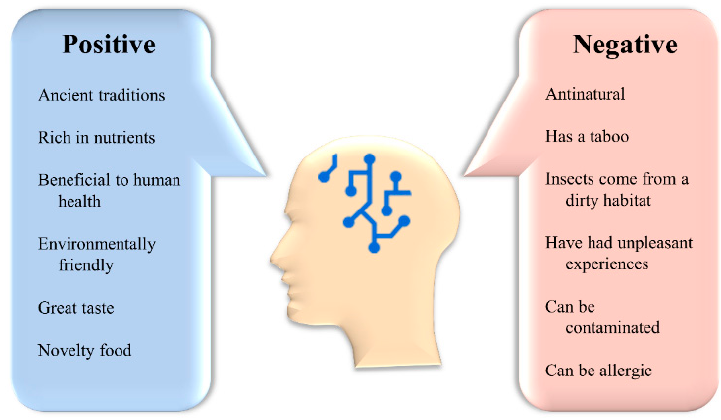
Figure 8. Different attitudes towards edible insects as food.